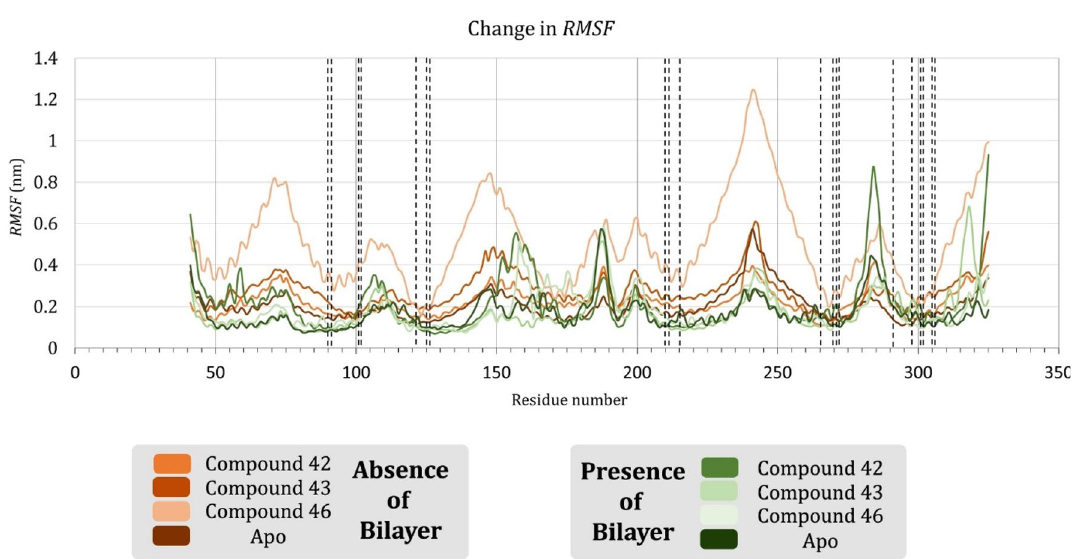
Figure 3. Comparing time evolution plots of the RMSF of SSTR2 amino acid residues in the presence and absence of a lipid bilayer. SSTR2 showed lesser fluctuation throughout the simulation than in the absence of